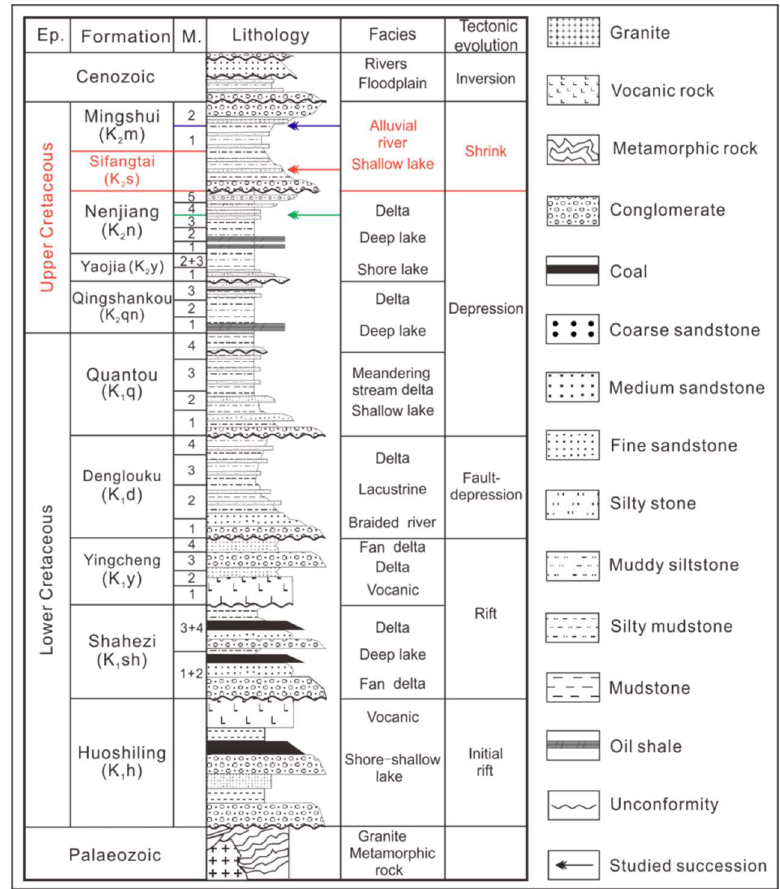
Figure 5. Generalized stratigraphic column of Songliao Basin. It is modified from Hu et al. in 2019 [12]. Ep. = epoch, M. = member.